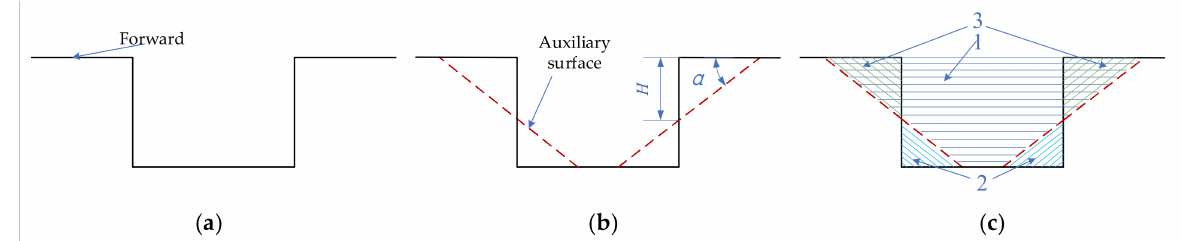
Figure 3. Division of forming area: ( a ) the straight-wall part model; ( b ) auxiliary surface; ( c ) forming